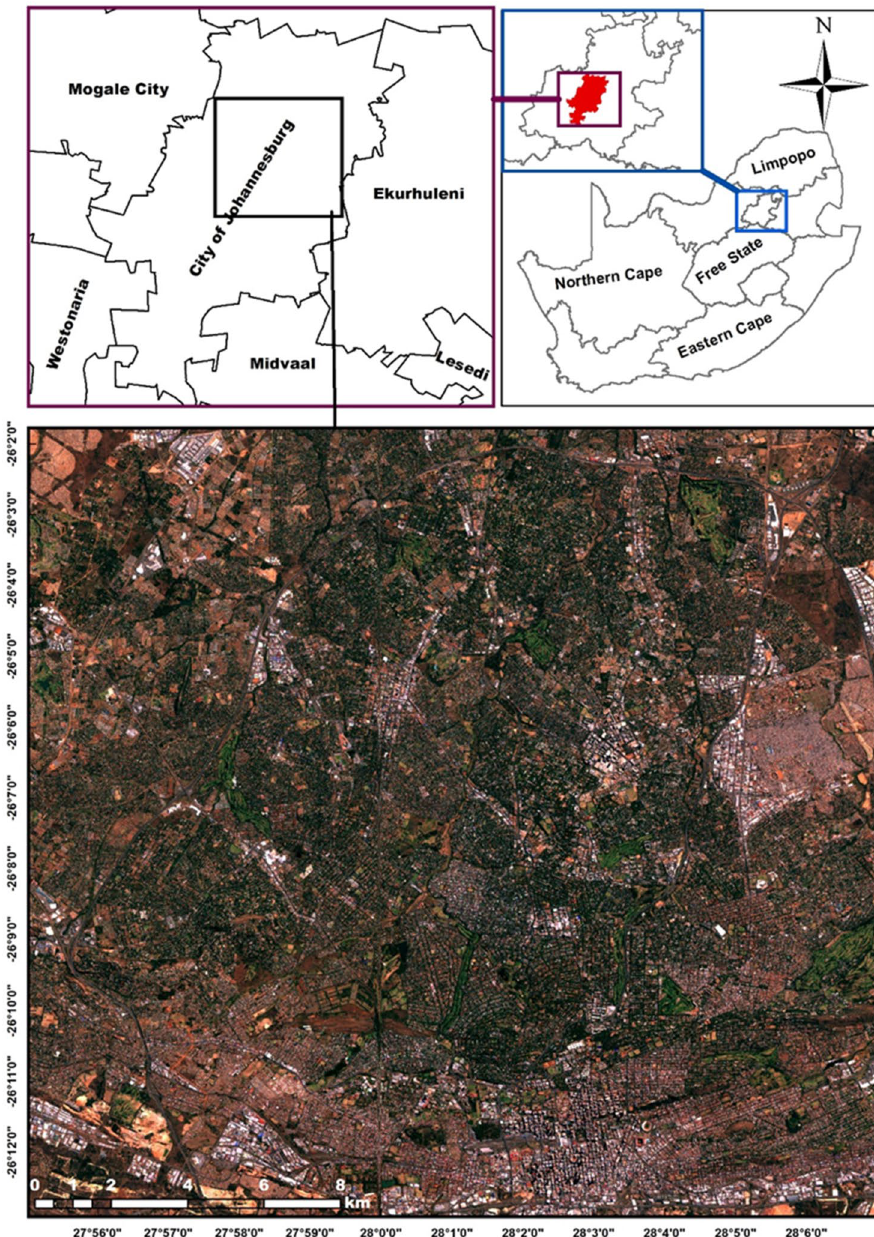
Figure 1. location of the study area (mainly in the north), at the city of Johannesburg, South Africa including the affluent largely white suburbs (Houghton, Rosebank, Sandton, Braamfontein) and parts of the Alexandra Township. The SPOT 6 pan-sharpened images was obtained from the South African National Space Agency (SANSA) and generated using the ArcGIS desktop software version